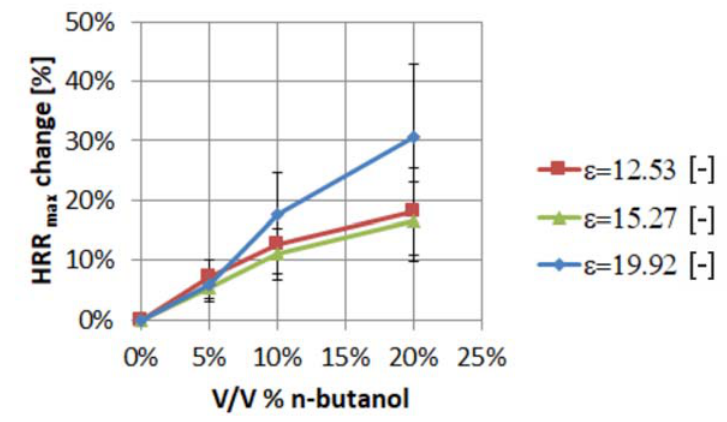
Figure 4. Change in maximum useful heat change (HRR) compared to diesel (0 V/V% n-butanol) under different compression ratios and n-butanol ratios.